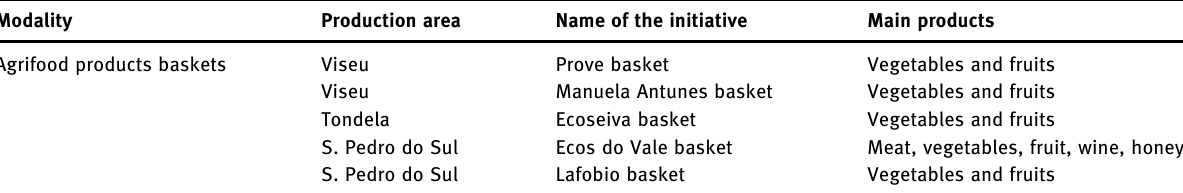
Table 2: Baskets of agrifood products